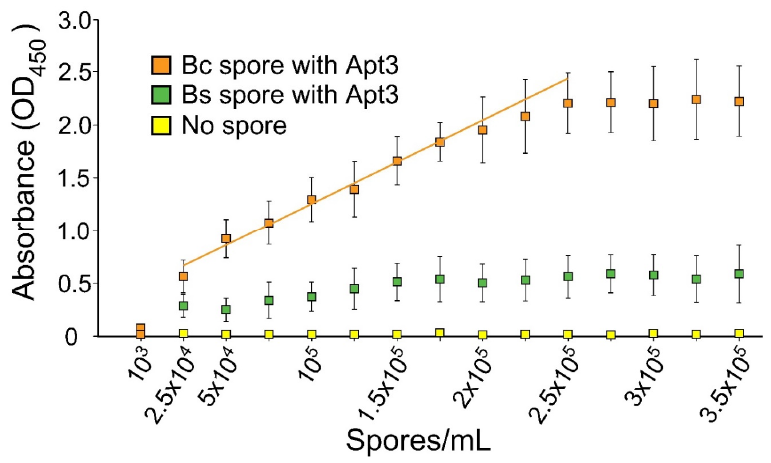
Figure 5. Range of detection of Apt3 using ELISA. This experiment was repeated thrice. Error bars represent standard deviations. A trend line is shown to highlight the linear range of detection. Abbreviations: Bc, Bacillus cereus ; Bs, Bacillus subtilis .